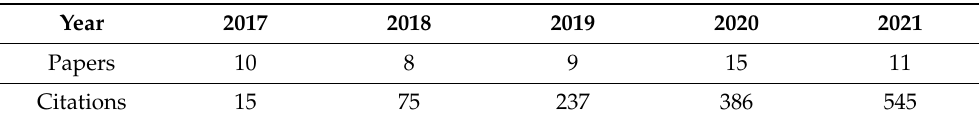
Table 2. Distribution of the selected surveys and their total number of citations (according to Scopus) by publication